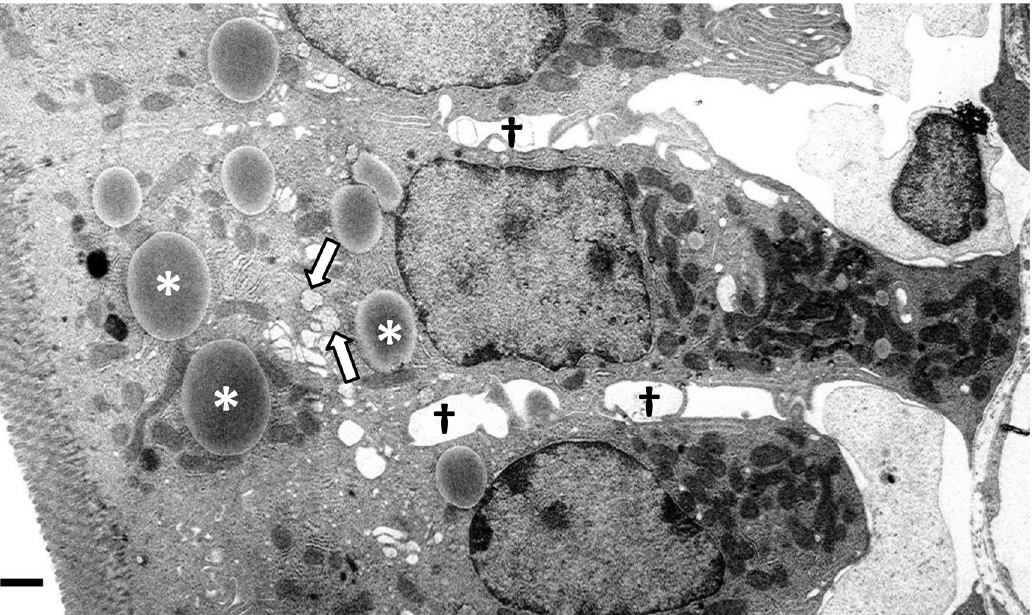
Fig 1. Lipid accumulates in CLDs in enterocytes in response to a dietary fat challenge. Representative transmission electron micrograph of a mouse enterocyte from the jejunum section of the small intestine, two hours after an 200 μ l olive oil bolus. Neutral lipids, stained with osmium tetroxide, accumulate in CLDs indicated by white asterisks. Golgi apparatus (white arrows) contain smaller chylomicron sized particles. White areas between enterocytes contain secreted chylomicrons (black cross). Scale bar, 1 μ